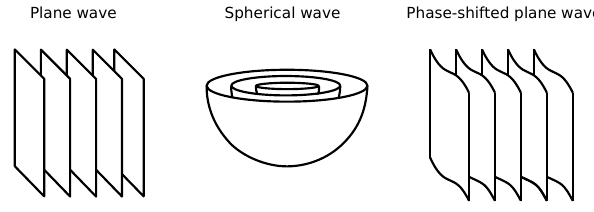
Fig. 3. Spatial patterns that can be used for the Capon’s projection technique, after Constantinescu (2007).